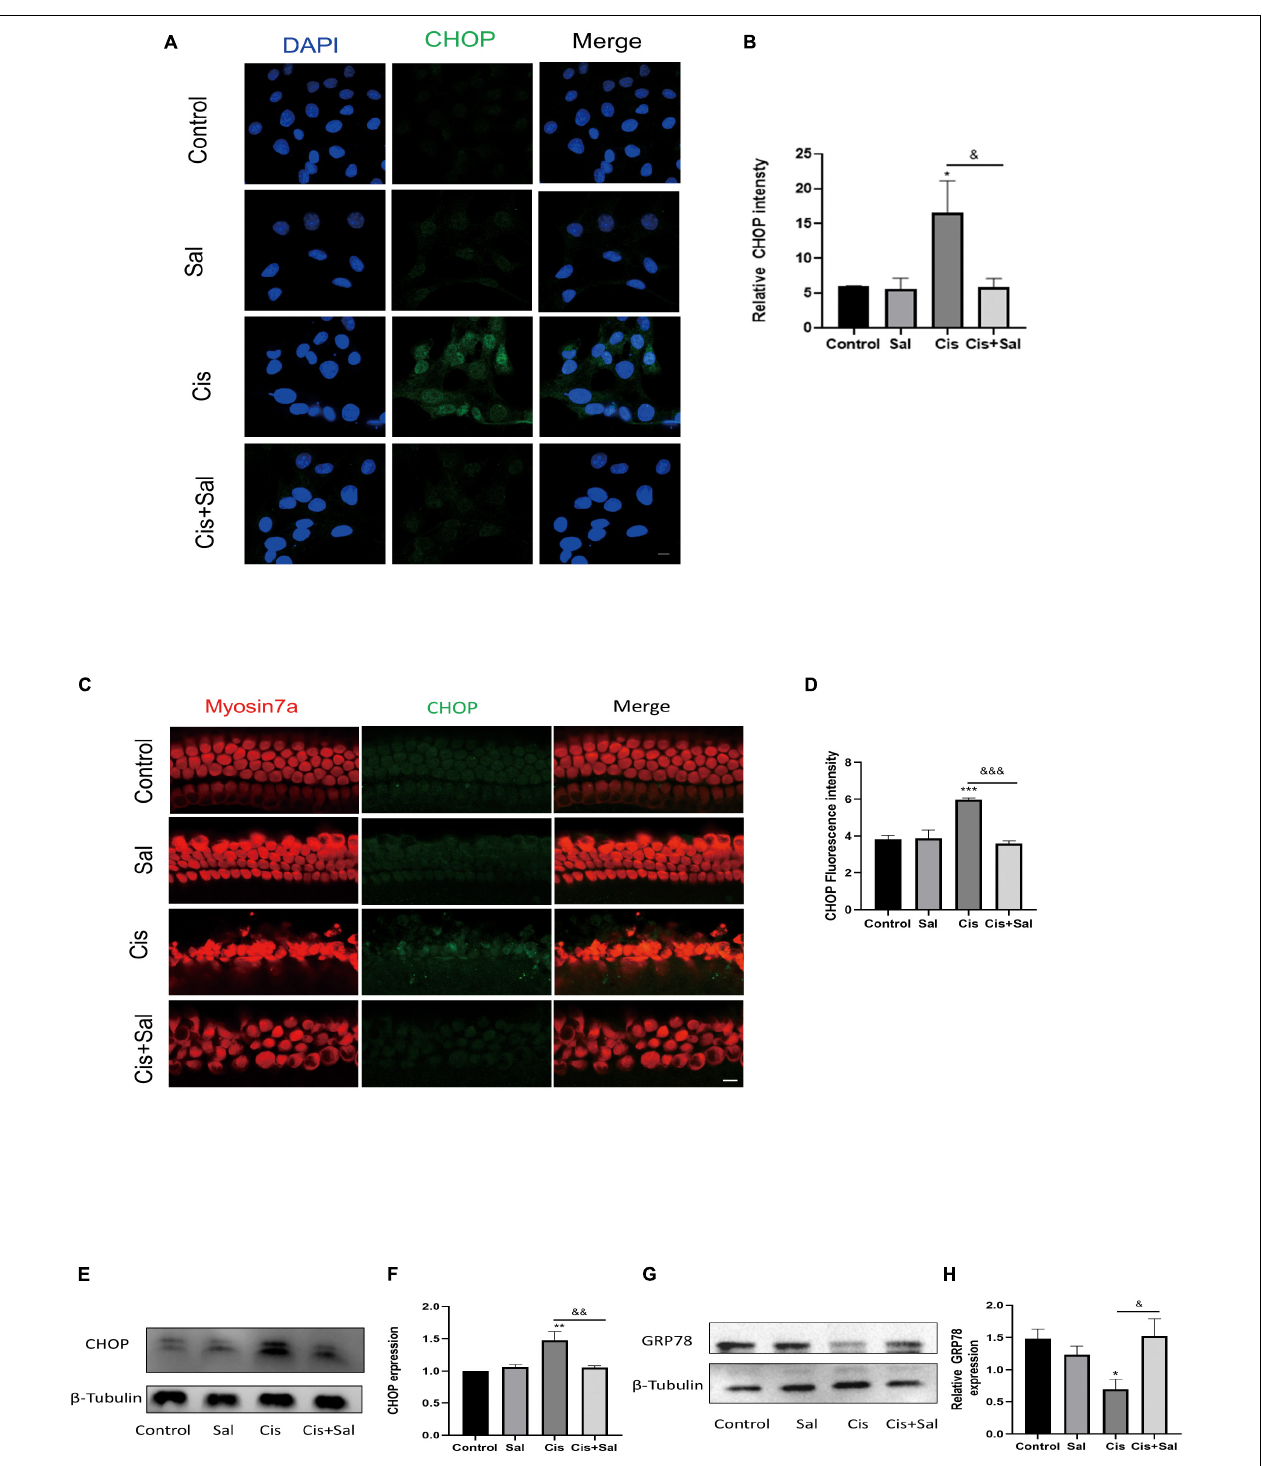
FIGURE 5 | Sal attenuates cisplatin-induced endoplasmic reticulum stress in HEI-OC1 cells. (A) HEI-OC1 cells in the different groups were labelled with CHOP ( n = 3). (B) Quantitative analysis of the data shown in (A) . (C) Cochlear basilar membranes in the different groups were labelled with CHOP ( n = 3). (D) Quantitative analysis of the fluorescence intensity shown in (C) . (E) Western blotting results showing CHOP expression in HEI-OC1 cells after different treatments ( n = 3). (F) Quantitative analysis of the data shown in (E) . (G) Western blotting results showing BIP expression in HEI-OC1 cells after different treatments ( n = 3). (H) Quantitative analysis of the data shown in (G) . Values are presented as mean ± SEM from independent experiments. * P < 0.05, ** P < 0.01, and *** P < 0.001 vs. the control group; & P < 0.05, && P < 0.01, and &&& P < 0.001 vs. the cisplatin group. Scale bars = 10 µ m.